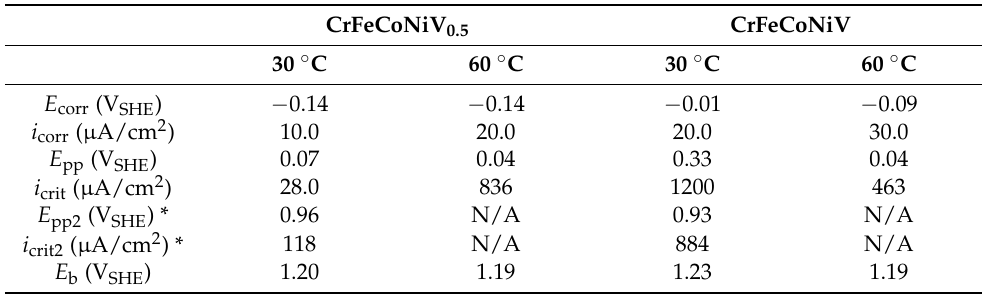
Table 5. Potentiodynamic polarization data of as-cast CrFeCoNiV x alloys in 1M deaerated HCl solution at different temperatures.